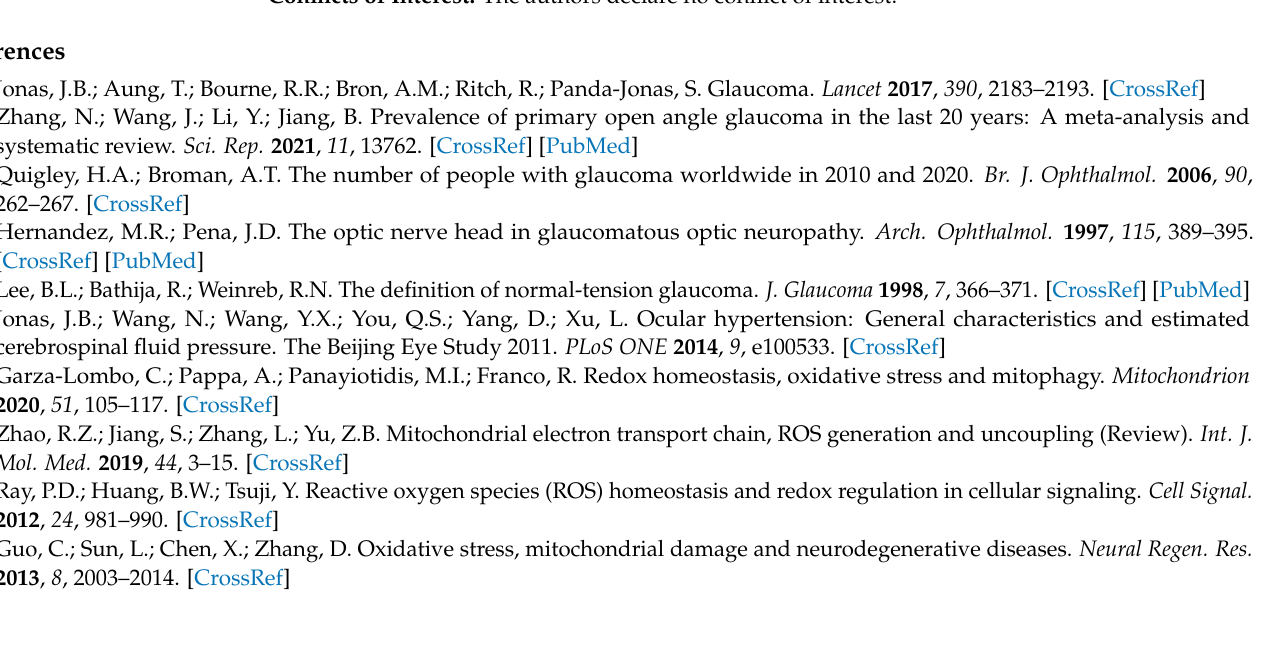
play a key role, thus, there is a clear unmet clinical need to address a disease modifying agent and this requires tackling a mechanism beyond IOP regulation.